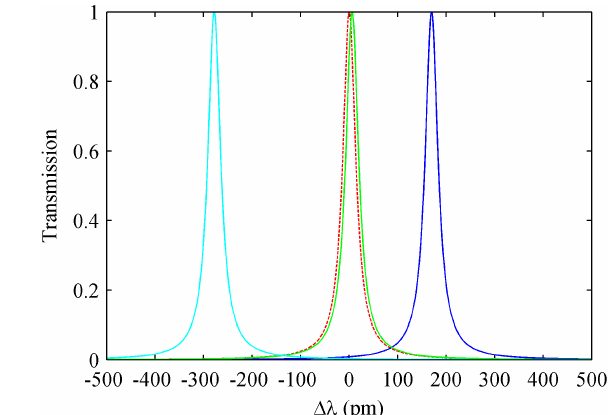
Figure 12. Sensitivity of the optimized sensor that has the structure shown in Fig.